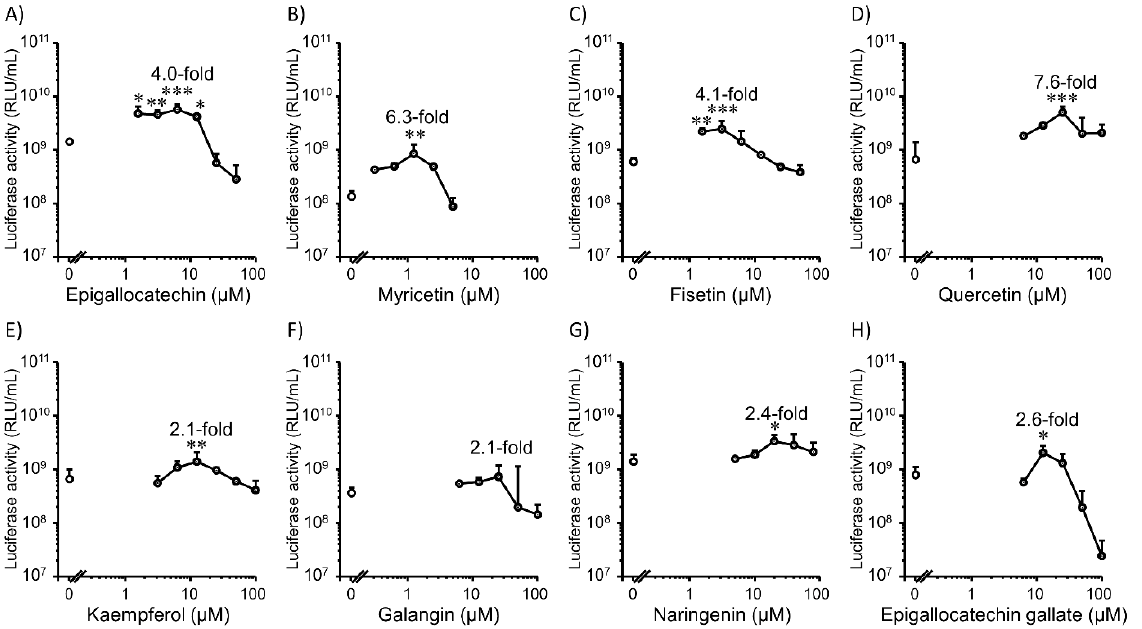
Figure 3. Effect of co-incubation with flavonoids on transfection efficiency mediated by Lipofectamine 3000/plasmid DNA (pcDNA3/GL 0.2 µg/well) complexes in 2D HepG2 cells. ( A ) Epigallocatechin (0–50 µM). ( B ) Myricetin (0–5 µM). ( C ) Fisetin (0–50 µM). ( D ) Quercetin (0–100 µM). ( E ) Kaempferol (0–100 µM). ( F ) Galangin (0–100 µM). ( G ) Naringenin (0–80 µM). ( H ) Epigallocatechin gallate (0–100 µM). Each dot represents the mean + SD ( n = 3). * p < 0.05, ** p < 0.01, *** p < 0.001 compared with the control (0 µM flavonoids).